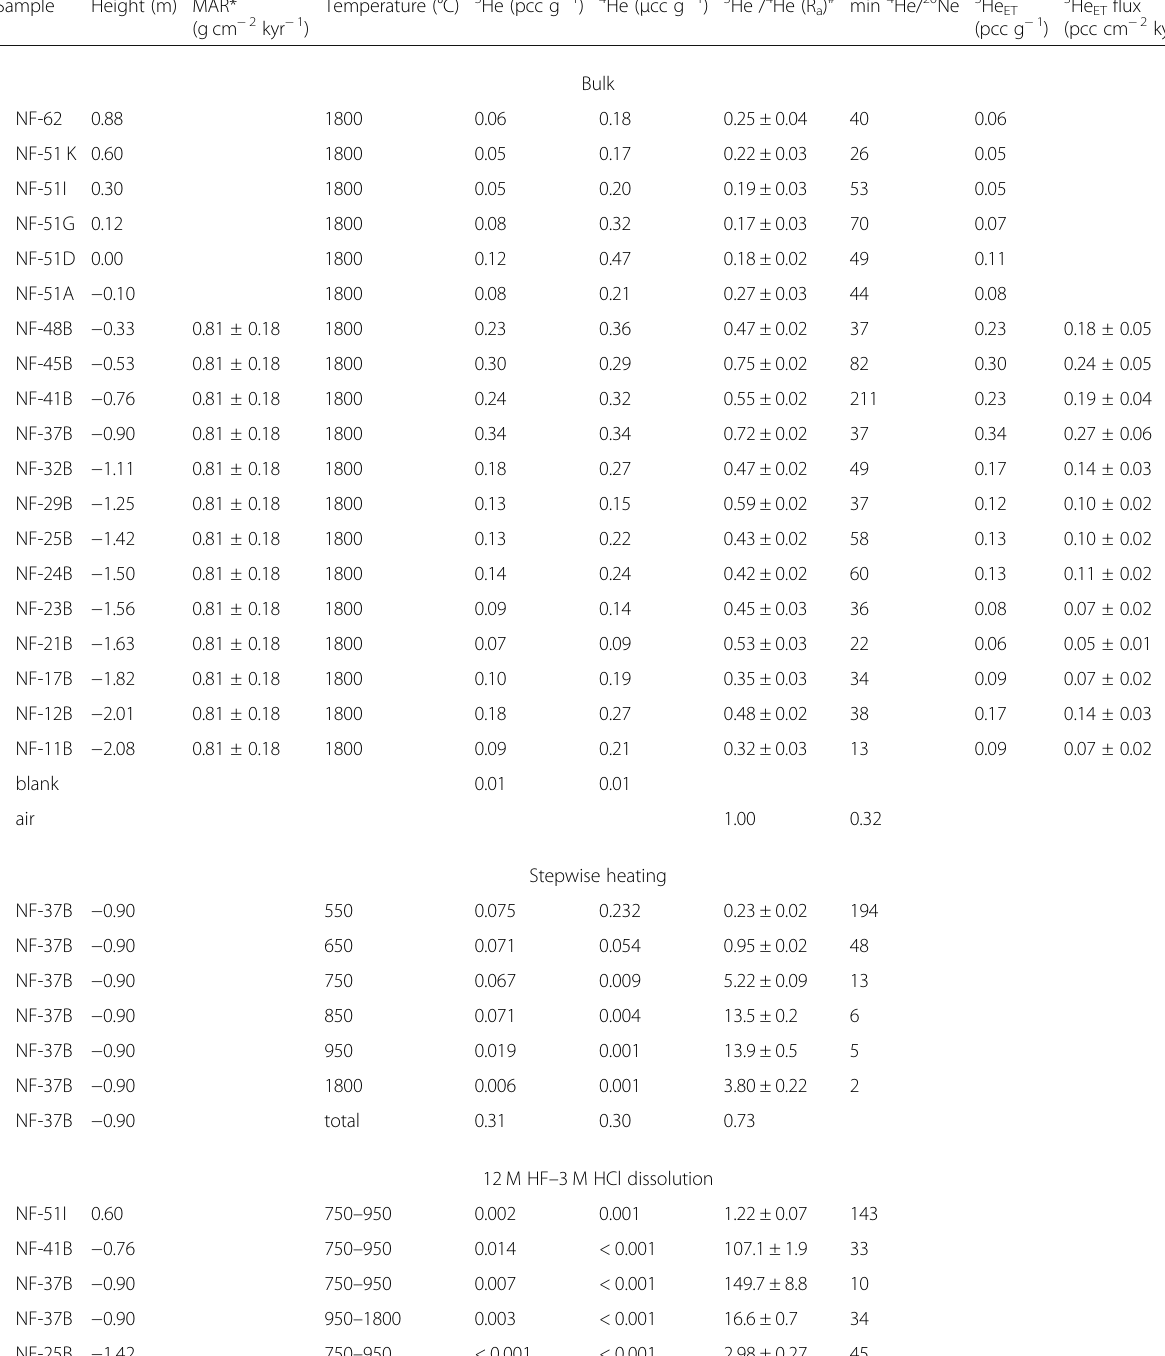
Table 1 3 He and 4 He concentrations, and 3 He/ 4 He ratios for samples from the Waidani section